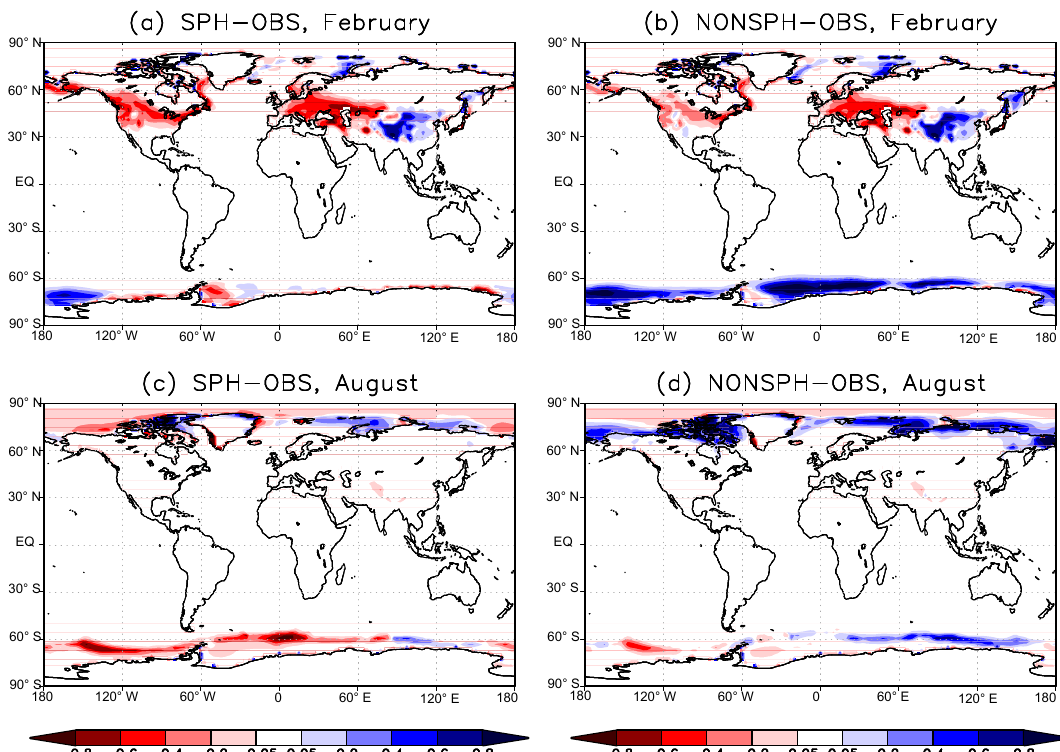
Figure 8. Differences in snow cover on land and in sea ice cover between the SPH and NONSPH experiments and observations (OBS) for the months of (a, b) February and (c, d) August. The observations for land snow cover are from the NOAA Northern Hemisphere snow cover extent CDR (Robinson et al., 2012; Estilow et al., 2015) and the sea ice observations from the NSIDC passive microwave sea ice concentration CDR (Meier et al., 2013; Peng et al., 2013), both averaged over 1990–2014.